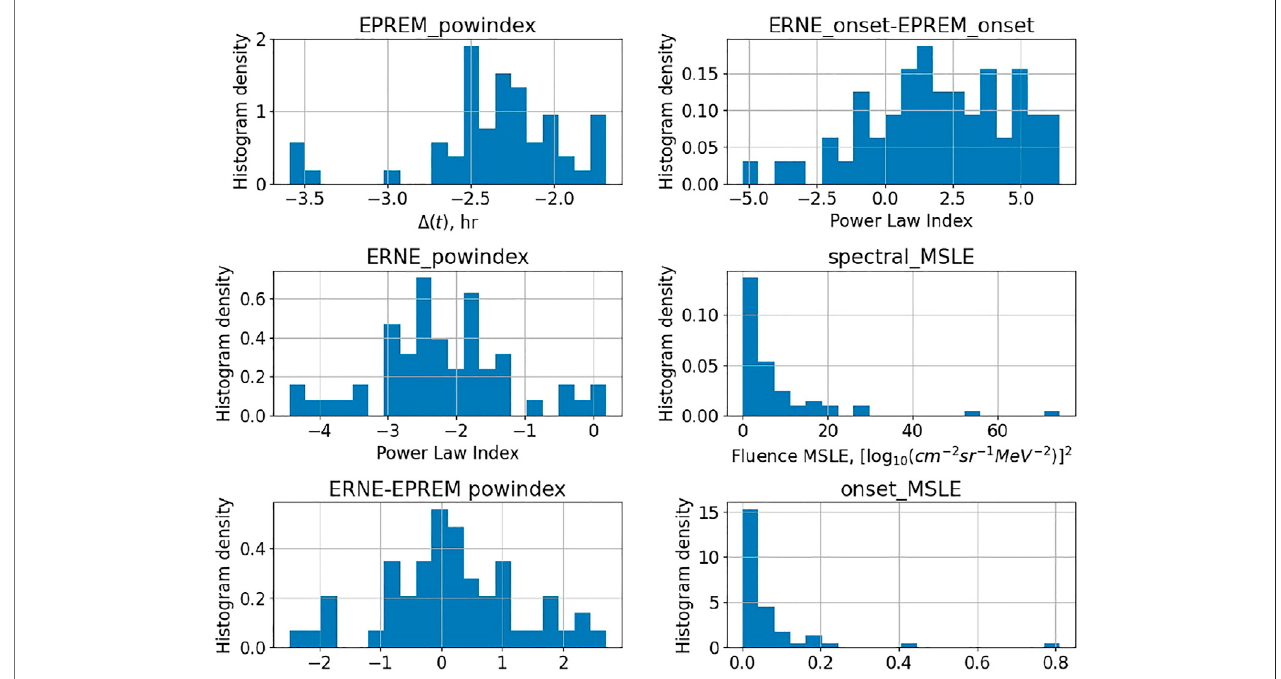
FIGURE 15 | A comparison between the modeled (yellow) and observed (blue) proton fl uences for the event. Power law fi t amplitudes and indices for both fl uence spectra are shown as well. The pre-event background ERNE fl uence, together with the power law fi t is also shown for reference.